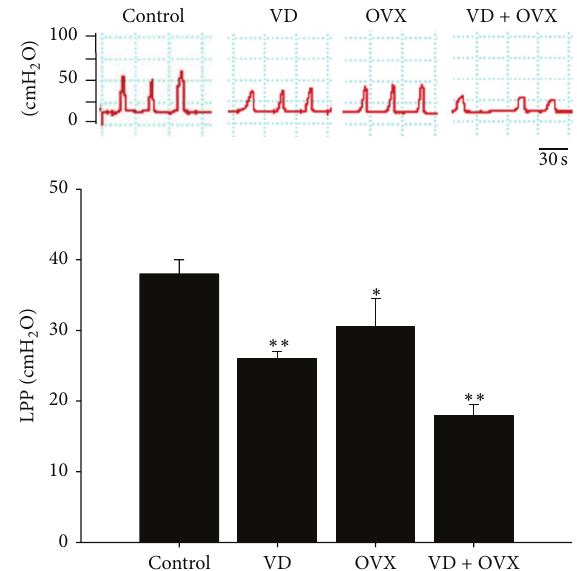
Figure 3: LPP values in the different groups. Each bar represents the mean ± SEM of six individual mice. ∗ 𝑃 < 0.05 compared to control group; ∗∗ 𝑃 < 0.01 compared to control